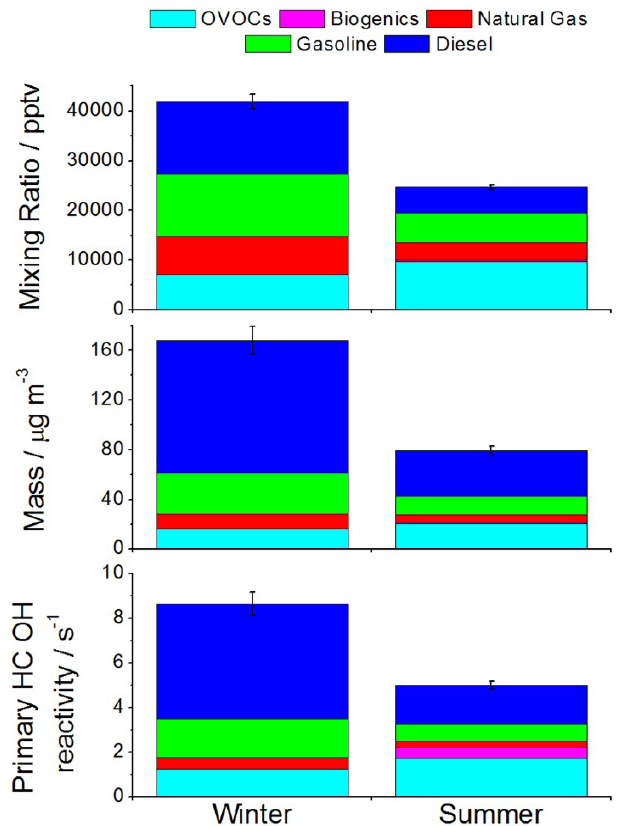
Figure 5. Contributions of emission source to total mixing ratio, mass and OH reactivity for winter and summer. Diesel is the sum- mation of measured and calculated, with error bars indicating the uncertainty of the unobserved diesel NMHC fraction.